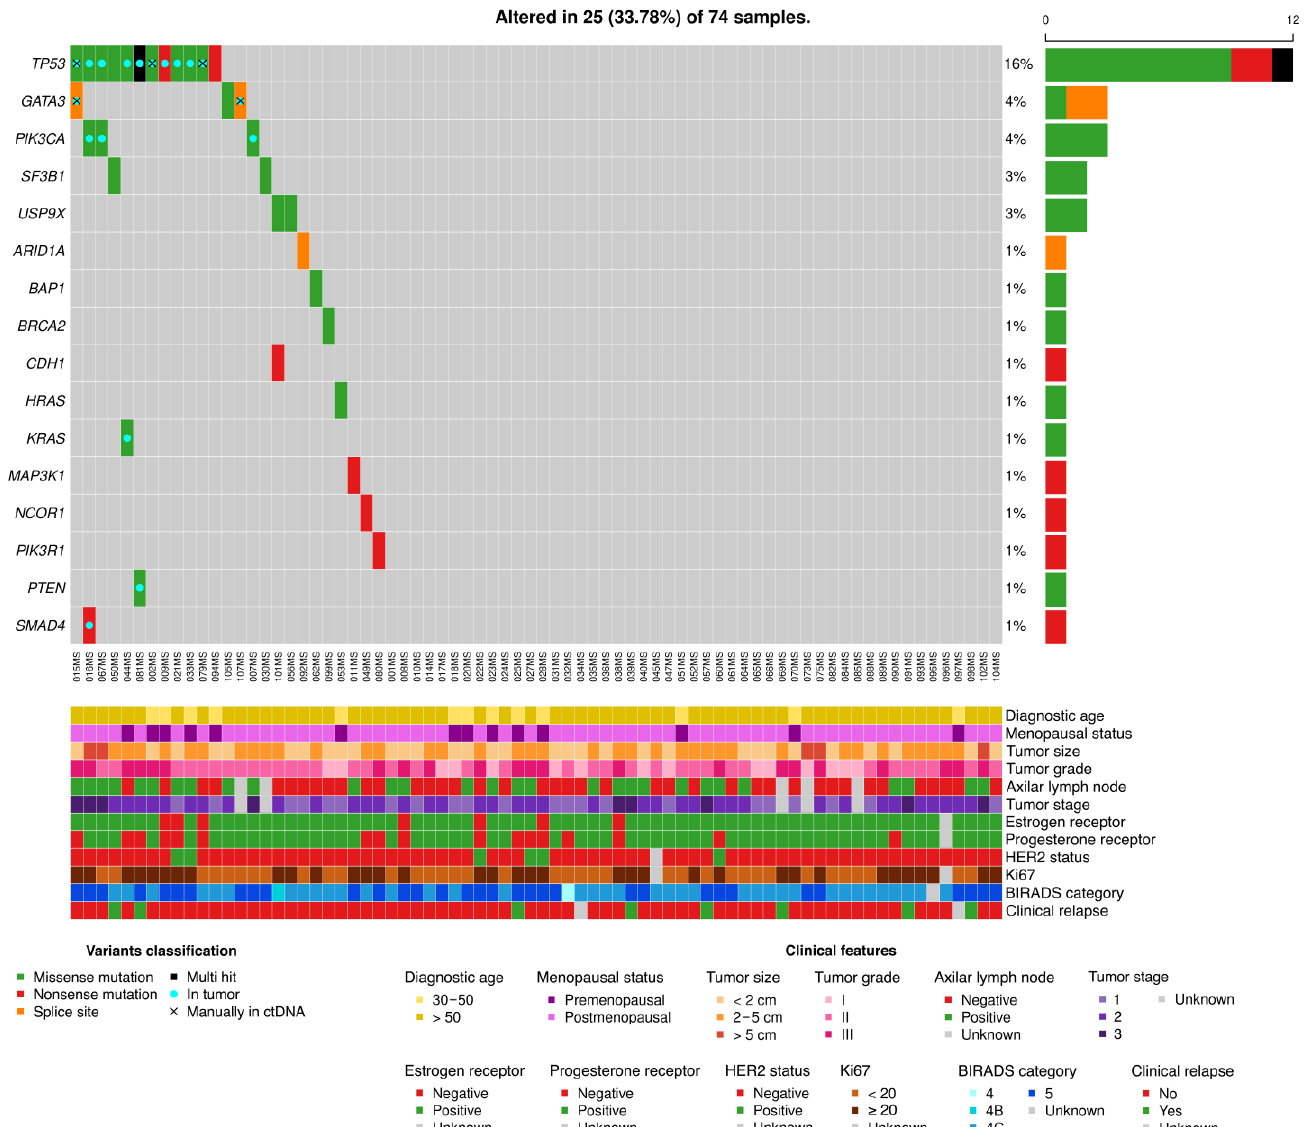
Figure 2. Somatic mutations observed in the plasma samples of localized BC patients. Top part. Mutations identified in the plasma samples both in the tumor and non-tumor informed sub-studies. Bottom part. Clinicopathological characteristics of the included patients showing the current clinical status (clinical relapse row).